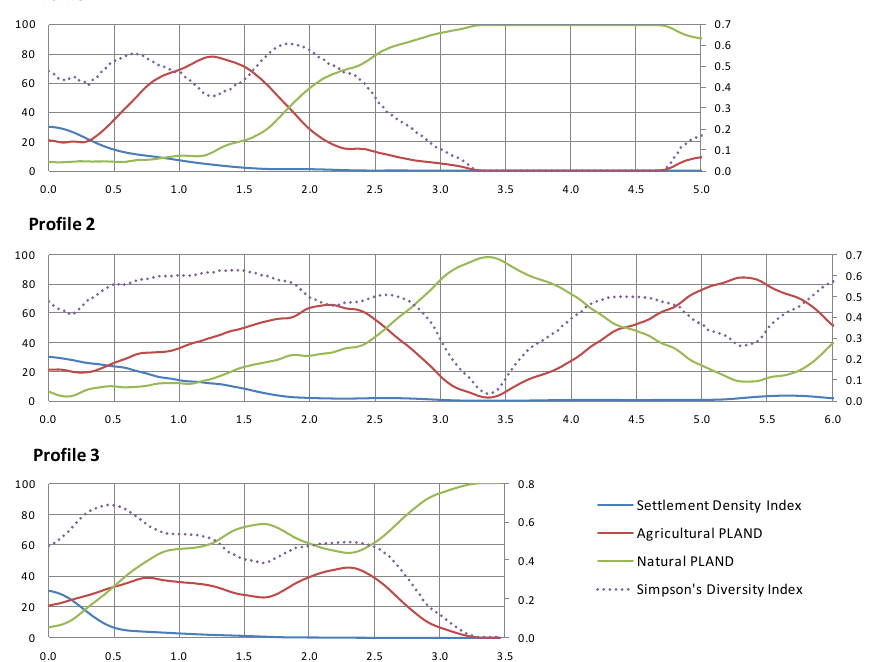
Fig. 13. Composition and diversity of the urban–rural gradient measured along the landscape profiles (year 2006). Settlement Density Index, agricultural and natural percentages of landscape (PLAND), and Simpson’s Diversity Index (SIDI). The latter is represented using the right graduation on the